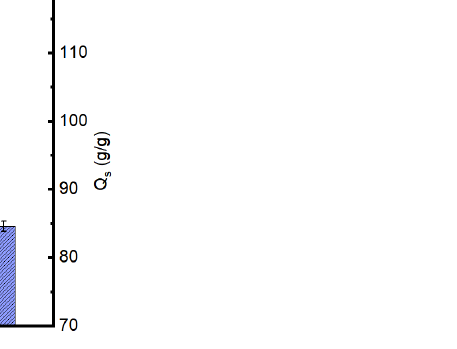
Figure 6. AUL of SAP0, SAP1, SAP2, and SAP3.